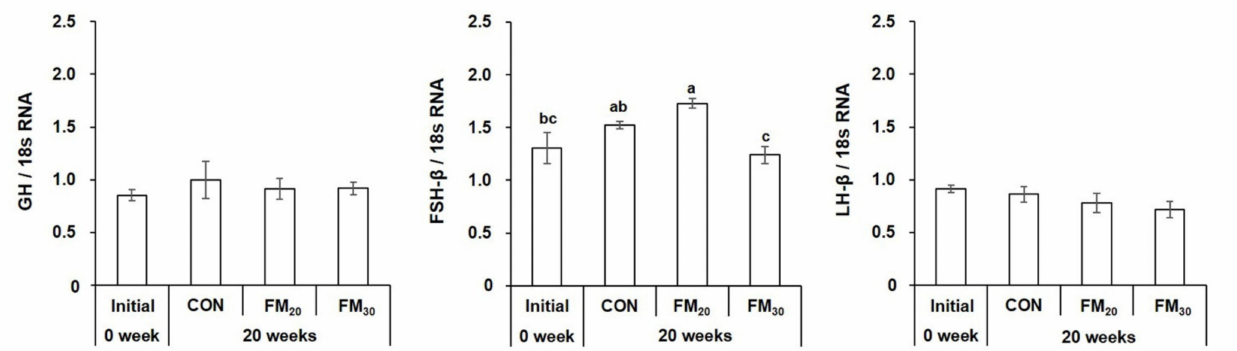
Figure 6. Expression of growth hormone (GH), follicle-stimulating hormone (FSH)- β , and luteinizing hormone (LH)- β mRNA in the olive flounder Paralichthys olivaceus. Data are presented as the mean ± SEM ( n = 10). Different letters above the bars indicate significant differences ( p < 0.05) between groups. CON, control diet; FM 20 , diet with 20% of the fishmeal replaced; FM 30 , diet with 30% of the fishmeal